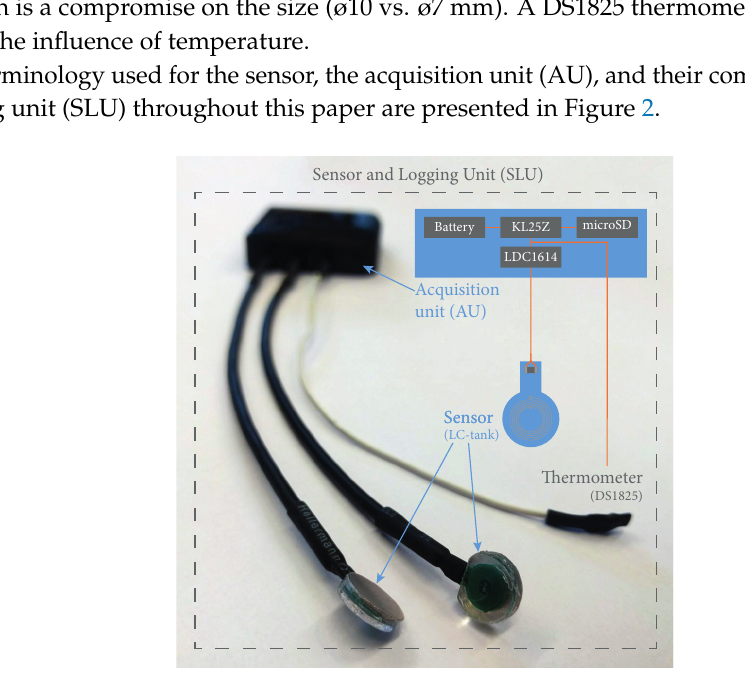
Figure 2. Two sensors and an acquisition unit (AU). The AU (top) allows the connection of two sensors (below) and a thermometer (right). Schematic representation of a sensor and logger to explain the distinction between sensor, AU, and the combination of the two: the sensing and logging unit (SLU).